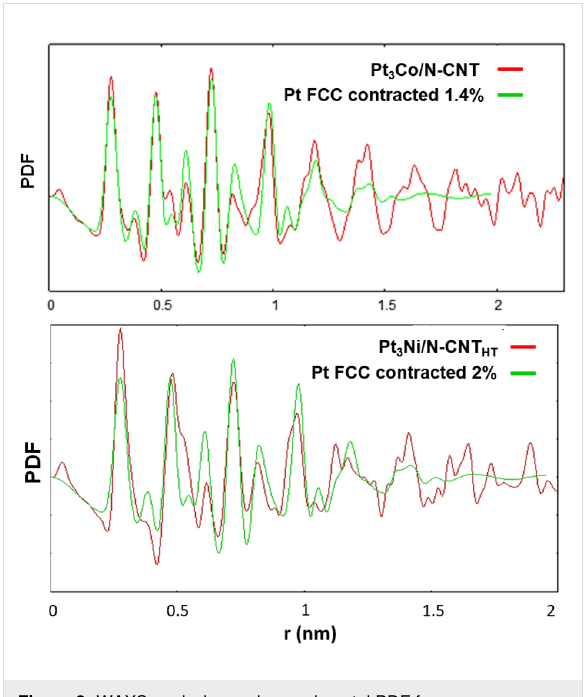
Figure 8: WAXS analysis – red: experimental PDF from a) Pt 3 Co/N-CNT and b) Pt 3 Ni/N-CNT HT , green: simulation from a spherical pure Pt